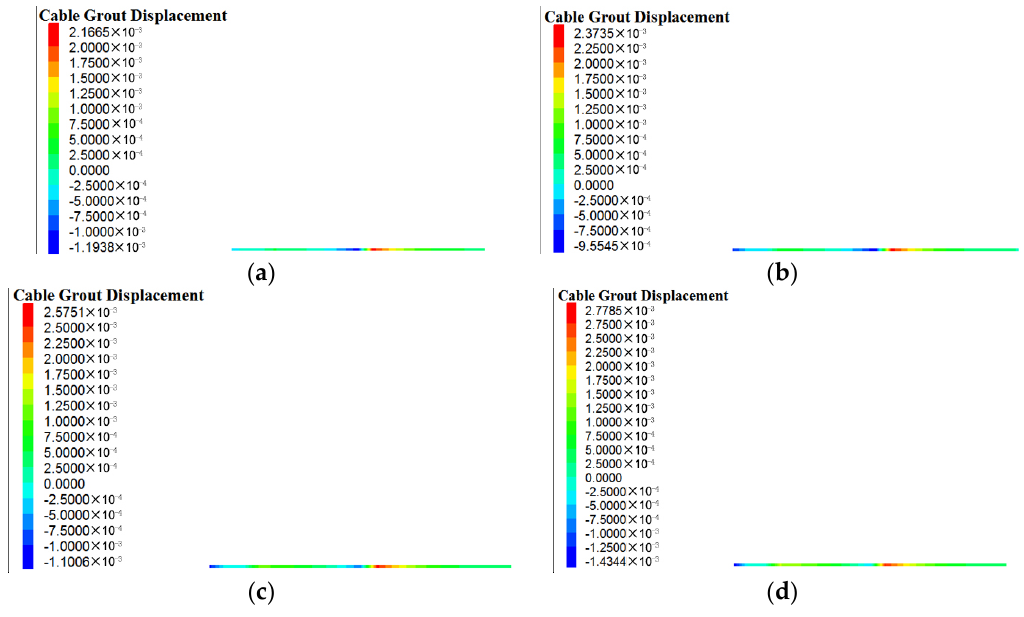
Figure 11. Cloud image of the cable grout displacement under di ff erent prestress (with fracture ap- erture of 4 mm). ( a ) Prestress = 20 kN; ( b ) prestress = 40 kN; ( c ) prestress = 60 kN; ( d ) prestress = 80 kN.